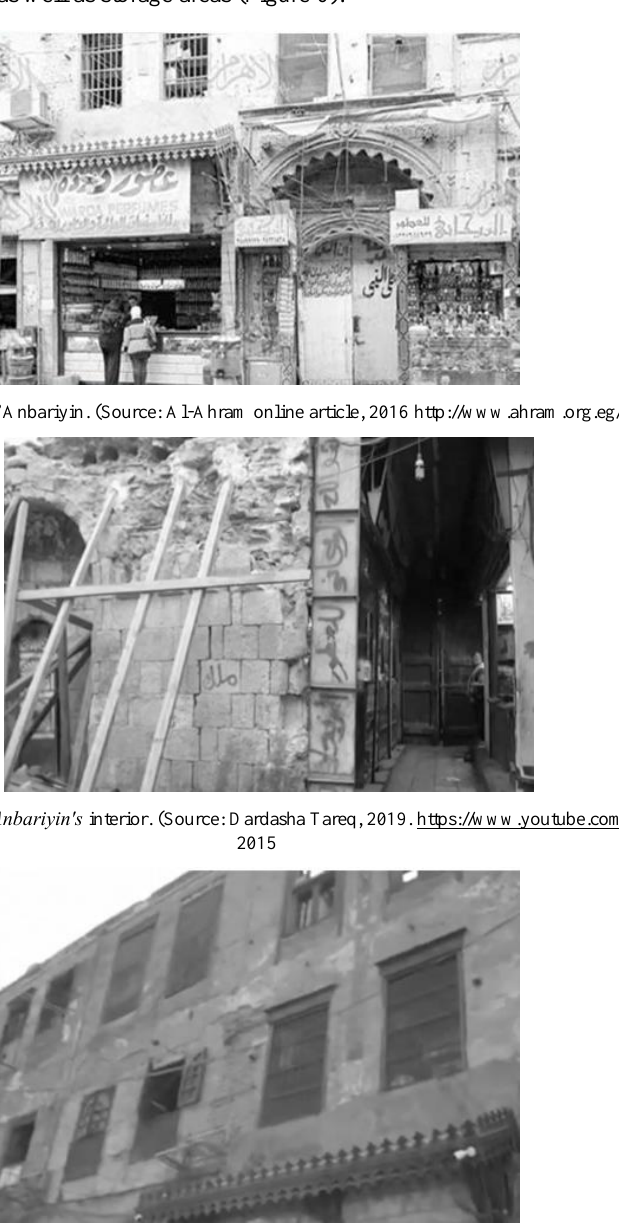
Figure 5. Deterioration in the elevation of Wikāliẗ ạl-’Anbariyin . (Source: Dardasha Tareq, 2019. https://www.youtube.com/watch?v=-